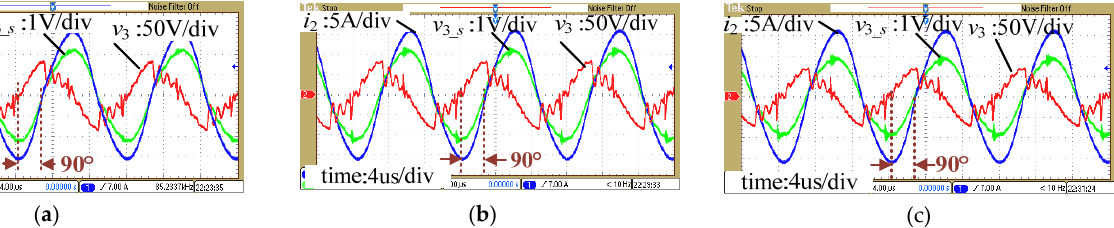
Figure 13. Experimental waveforms of v 3 , v 3_s , and i 2 under the condition of ( a ) ∆ X = ∆ Y = 0 cm; ( b ) ∆ X = 0 cm and ∆ Y = 6 cm; ( c ) ∆ X = 4 cm and ∆ Y = 0 cm. ( ∆ Z = 10cm).